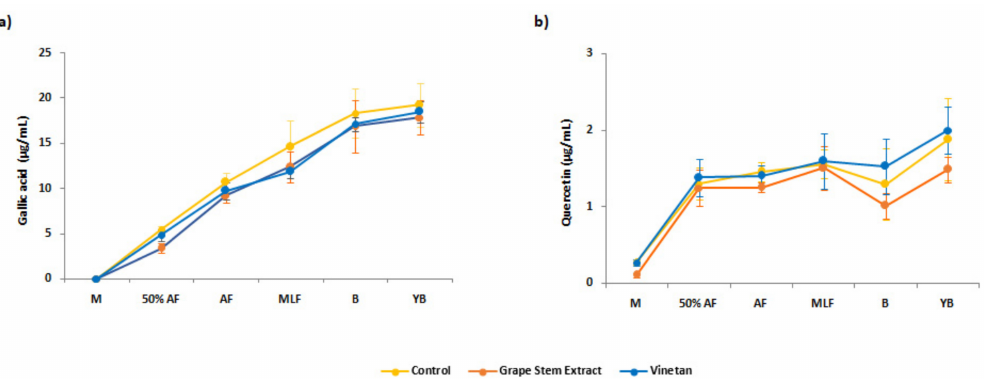
Figure2. Concentration( µ g / mL)ofgallicacid( a )andquercetin( b )duringthewinemakingprocessofthe control samples and samples with the addition of grape stem extract or commercial extract (Vinetan ® ). Results were obtained by HPLC-DAD analyses. M, must; 50%AF, 50% alcoholic fermentation; AF,